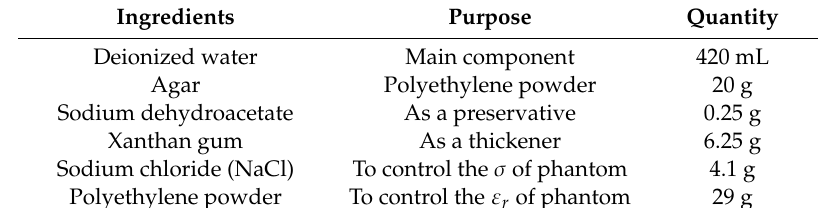
Table 2. Chemical composition of the human muscle phantom.